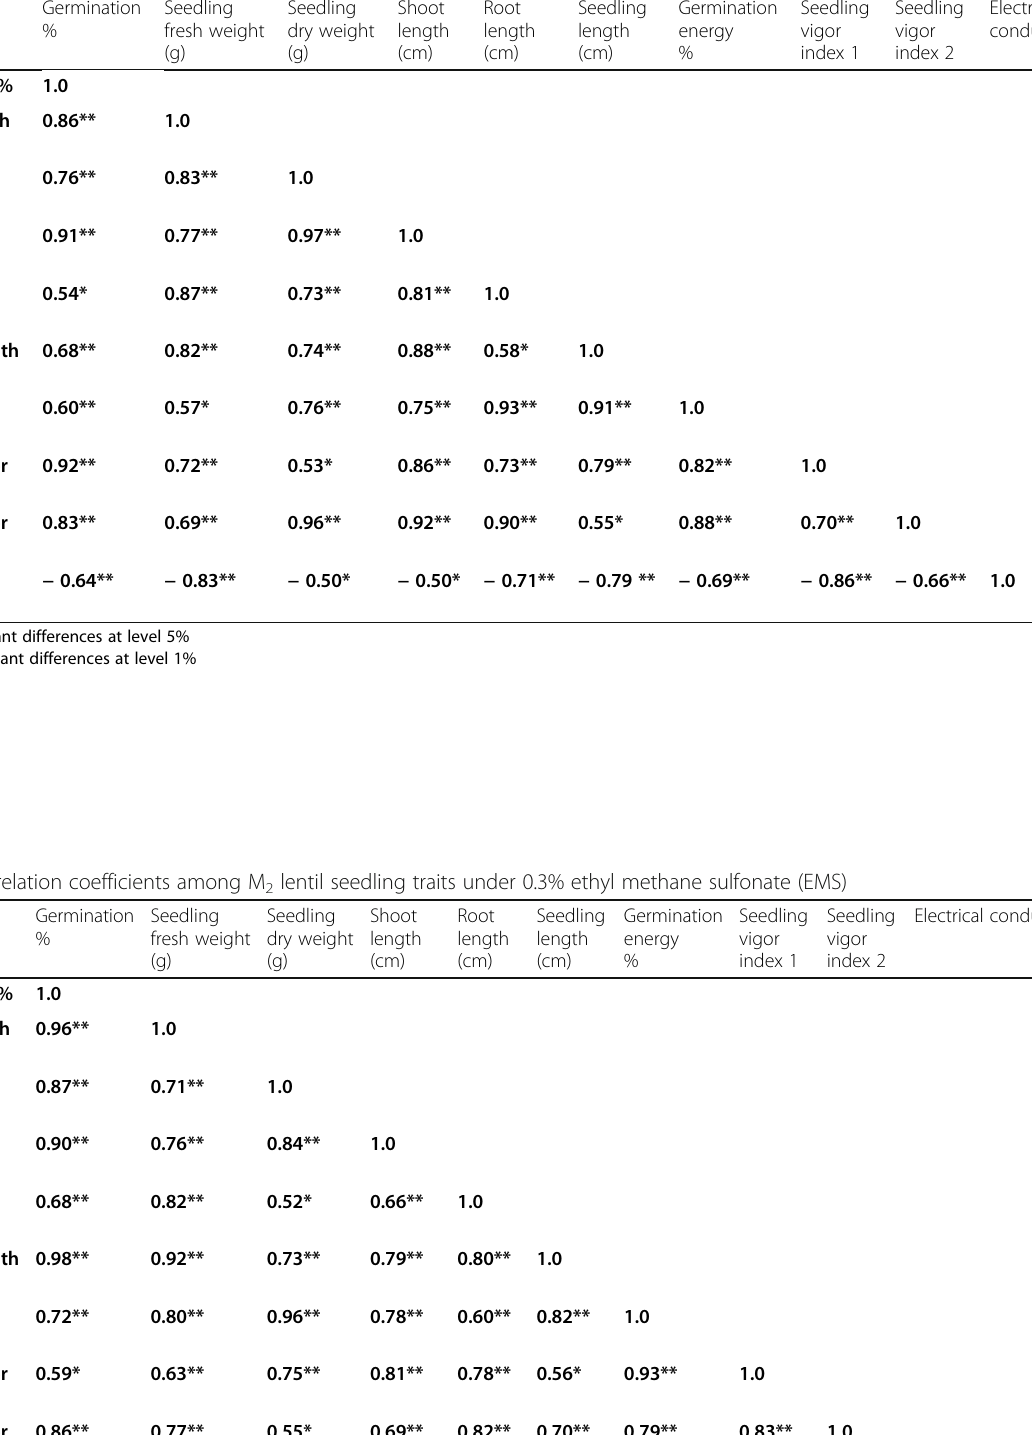
Table 5 Correlation coefficients among M2 lentil seedling traits under 0.2% ethyl methane sulfonate (EMS) Traits